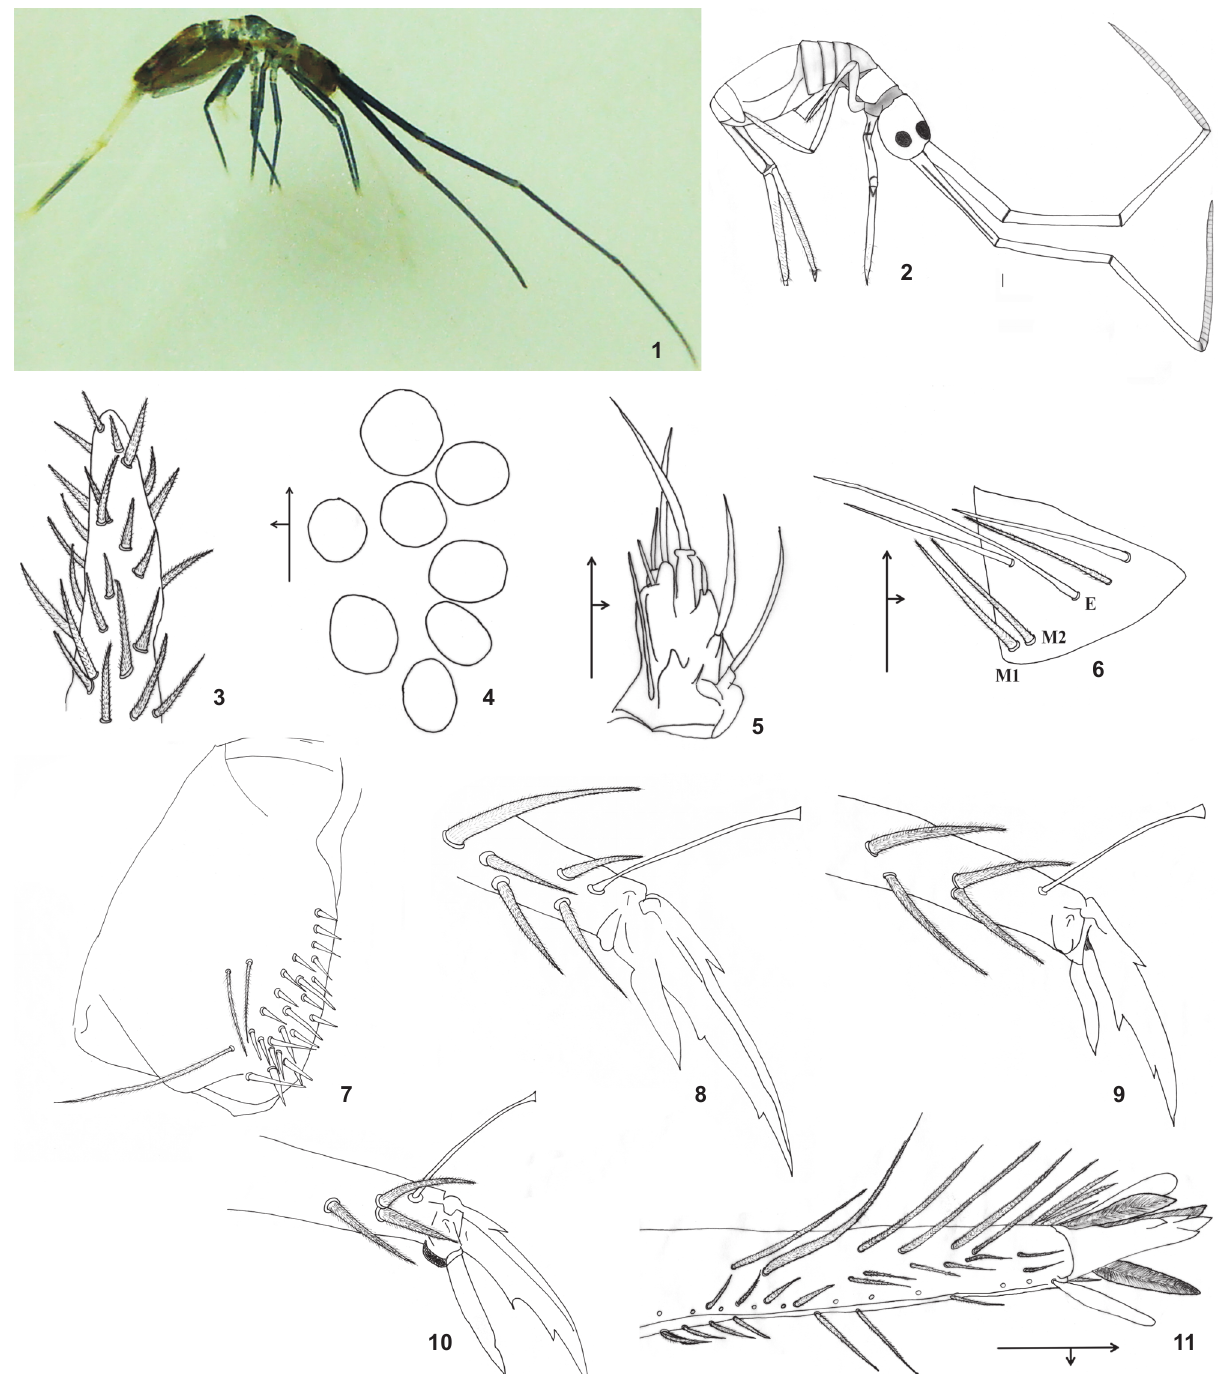
Figures 1-11. (1) Fixed specimen of Campylothorax mitrai sp. nov. ; (2) habitus with scale; (3) apical region of the antennal segment IV; (4) left eyepatch; (5) right labial palp; (6) setae of the labial triangle (right side); (7) trochanteral organ; (8) first foot complex; (9) second foot complex; (10) third foot complex; (11) distal dens and mucro. Scale bar = 100 ZOOLOGIA 29 (5): 451–454, October, 2012